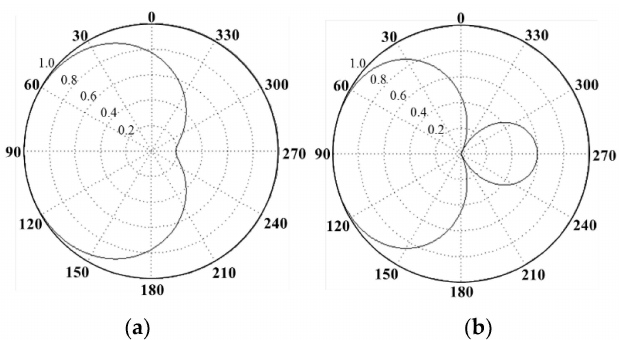
Figure 2. Directivity patterns of the DS beamformer ( l = 3 cm, direction = 90 ˝ ) at ( a ) 2.5 kHz and ( b ) 4 kHz.